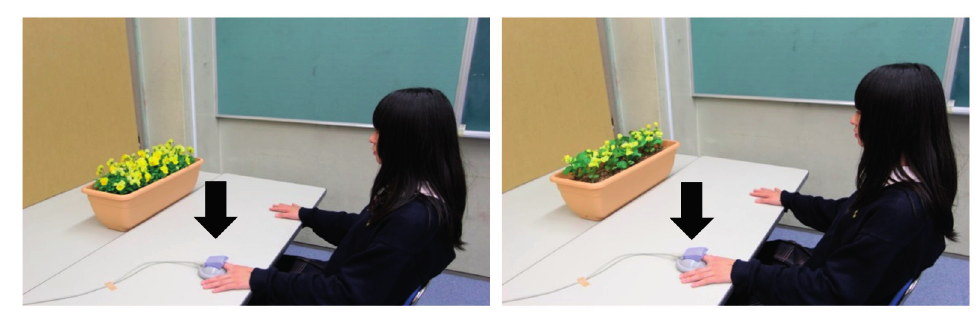
Figure 1. Visual stimulation with real flowers (left) and artificial flowers (right). The black arrow indicates the accelerated plethysmograph (ARTETT; U-medica, Inc.,